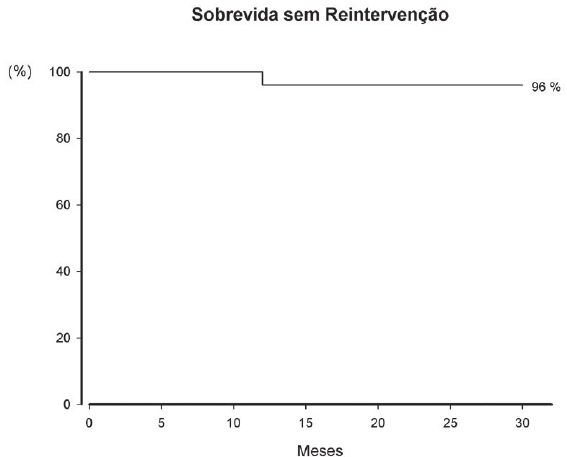
Fig. 4 - Curva de sobrevida livre de reintervenção relacionada ao procedimento endovascular em até 27